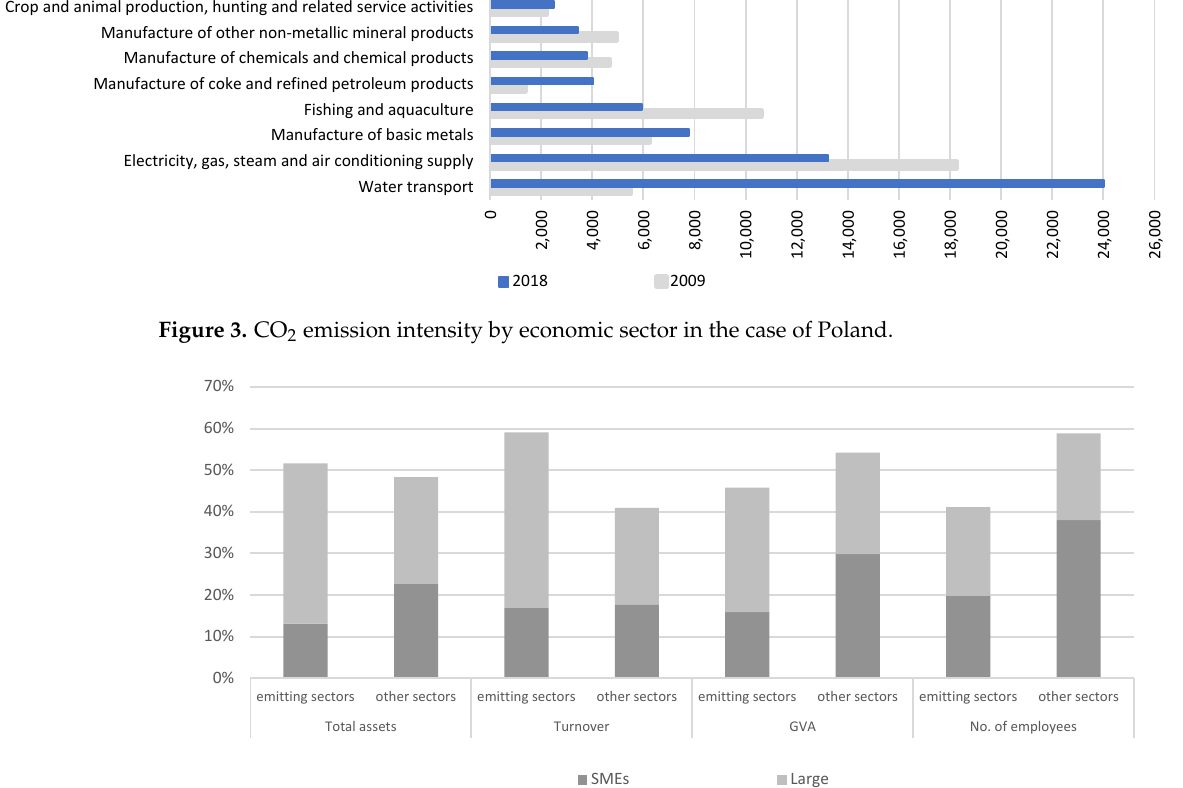
Figure 3. CO 2 emission intensity by economic sector in the case of Poland.